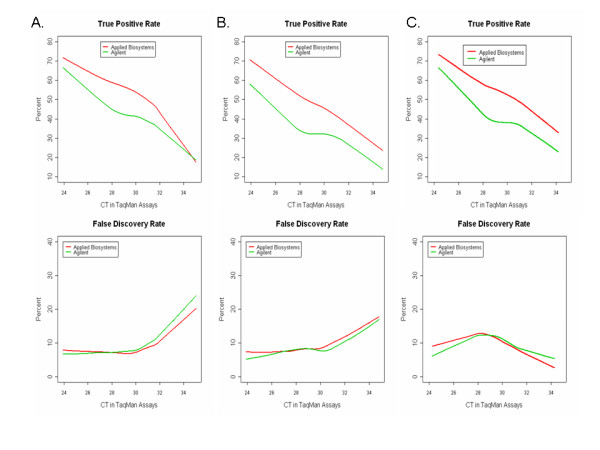
Sensitivity and specificity in detection of differential expression at different expression levels. For each platform, significantly differentially expressed genes for any given pair-wise tissues are determined as p-value < 0.05 using a student t-test (Panel A), using p-value adjusted according to Benjamini Horschberg multiple testing to control FDR at 5% (Panel B), or using a fold change cutoff (> 1.2-fold) for the TaqMan reference data sets while using a fold change cutoff (> 1.2-fold) and p-value < 0.05 based on t-test for microarray platforms (Panel C). Composite results for all three pairs of tissues (Brain vs. Liver, Brain vs. Lung, and Liver vs. Lung) were plotted. Gene expression levels are ordered according to TaqMan® Gene Expression Assay measurements (average Ct between the three tissues, only genes detected in both tissues by TaqMan assays were analyzed). A sliding window containing 100 consecutive genes was constructed and moved one gene at a time to cover the whole range of Ct values. Within each sliding window, the True Positive Rate (upper panel) and False Discovery Rate (lower panel) of each microarray platform was computed and plotted as a function of gene expression level.